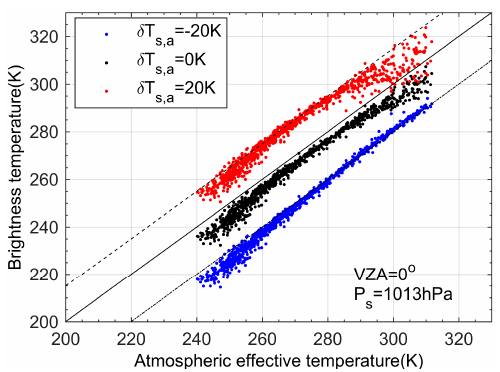
Figure 1. Brightness temperature of Moderate Resolution Imaging Spectroradiometer (MODIS) channel 31 versus atmospheric effective temperature for various δ T s,a values. Atmospheric effective temperature was defined by the DLR and atmospheric effective emissivity that was simulated using MODTRAN and 875 TIGR2002 profiles.